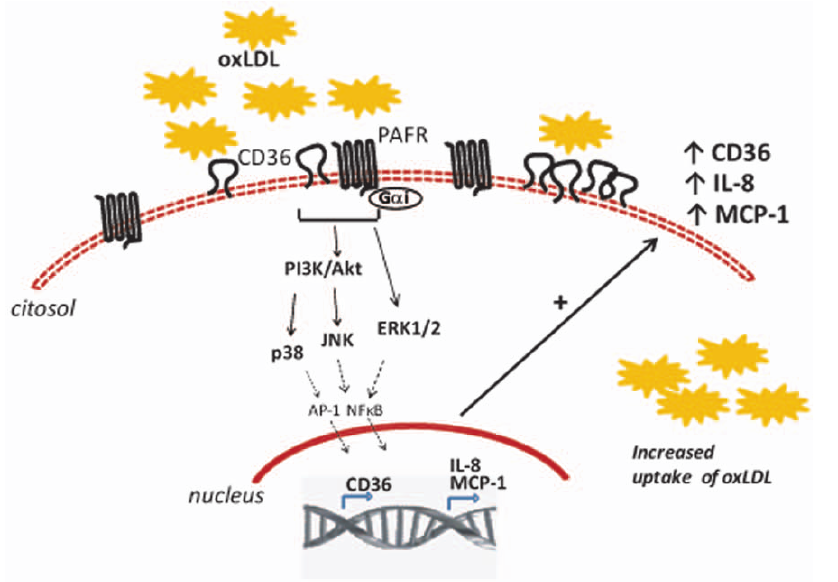
Figure 7. Based on these results we conclude that the addition of oxLDL to human monocytes/macrophages activates the PI3K/Akt pathway which in turn activates the p38 and JNK MAPK. Phosphorylation of Akt requires engagement of PAFR and a G a i-coupled protein. This should lead to NF k B and/or AP-1 activation and gene transcription. We found increased expression of CD36, IL-8 and MCP-1 mRNA in cells stimulated with oxLDL in a PAFR-dependent manner. Moreover, we observed increased expression of CD36 protein on macrophage membrane and increased uptake of oxLDL by these cells upon exposure to oxLDL which were also dependent on PAFR. By transfecting CD36 and PAFR to HEK 293t cells, we found that whereas each receptor per se was able to induce oxLDL uptake, both receptors were required for IL-8 production. These results point to an important role for PAFR in atherosclerosis by promoting foam cells formation because of the increased uptake of oxLDL and also by contributing to macrophage infiltration due to IL-8 and MCP-1 production. Thus, antagonists of PAFR might be a promising target for atherosclerosis treatment. Dashed lines represent data obtained from the literature [21].